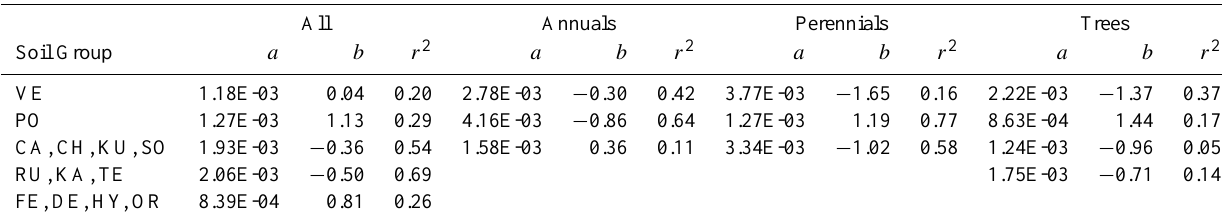
Table 1. Regression equations for lines in Fig.